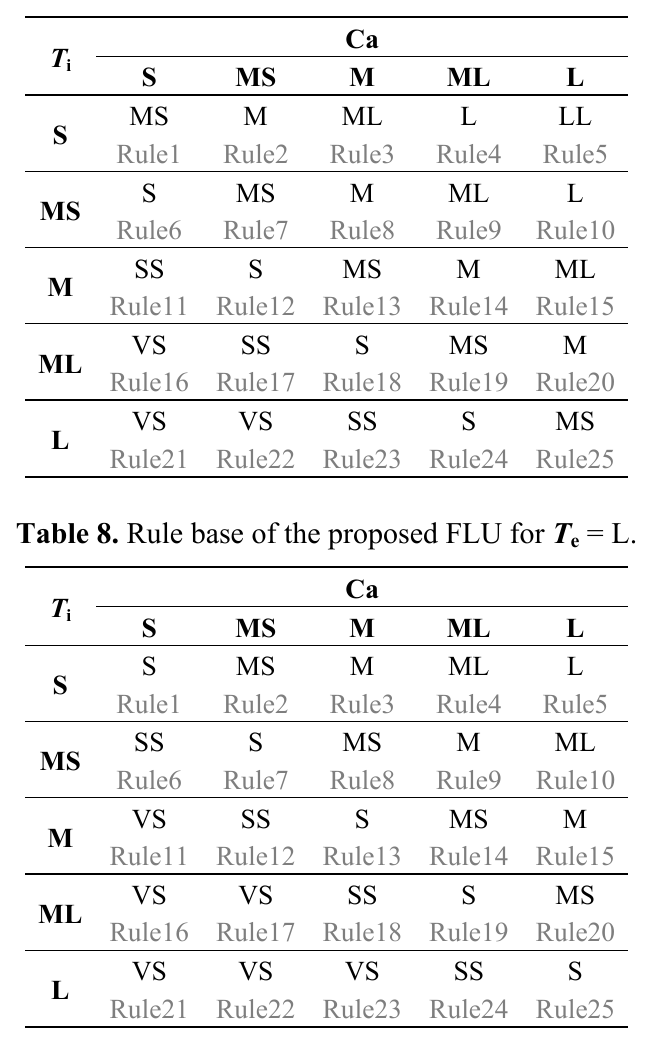
Table 7. Rule base of the proposed FLU for T